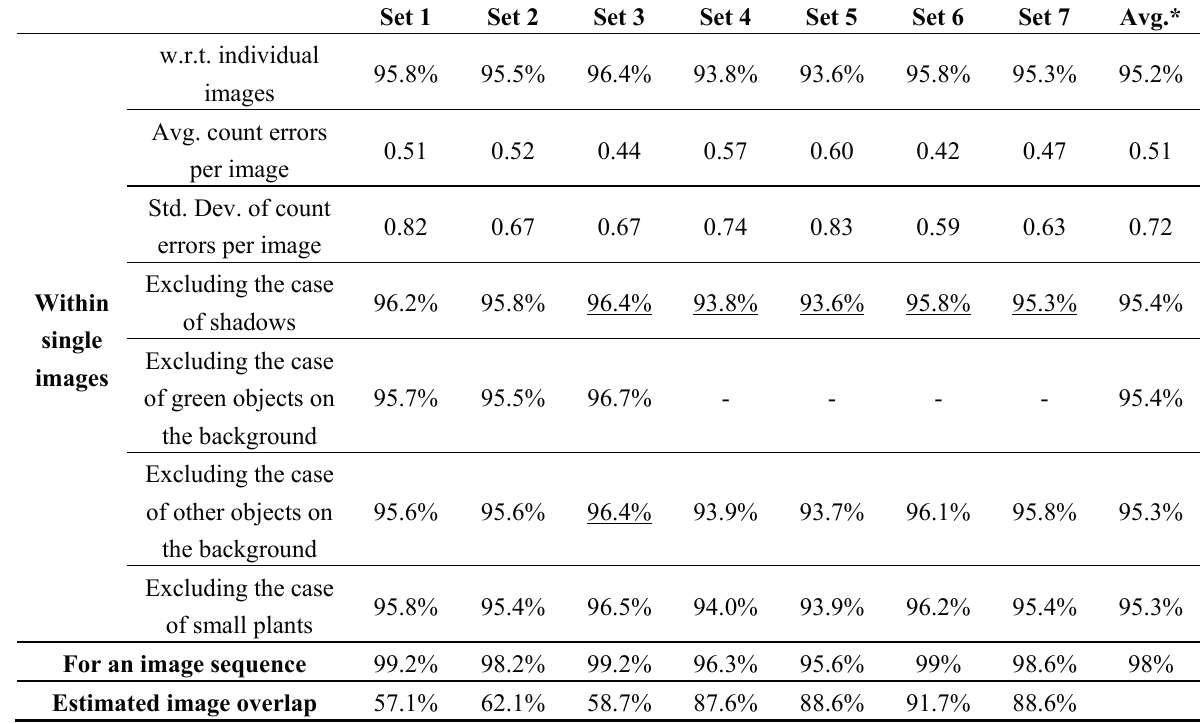
Table 2. Average counting accuracy and the estimated image overlap using a homography transform.